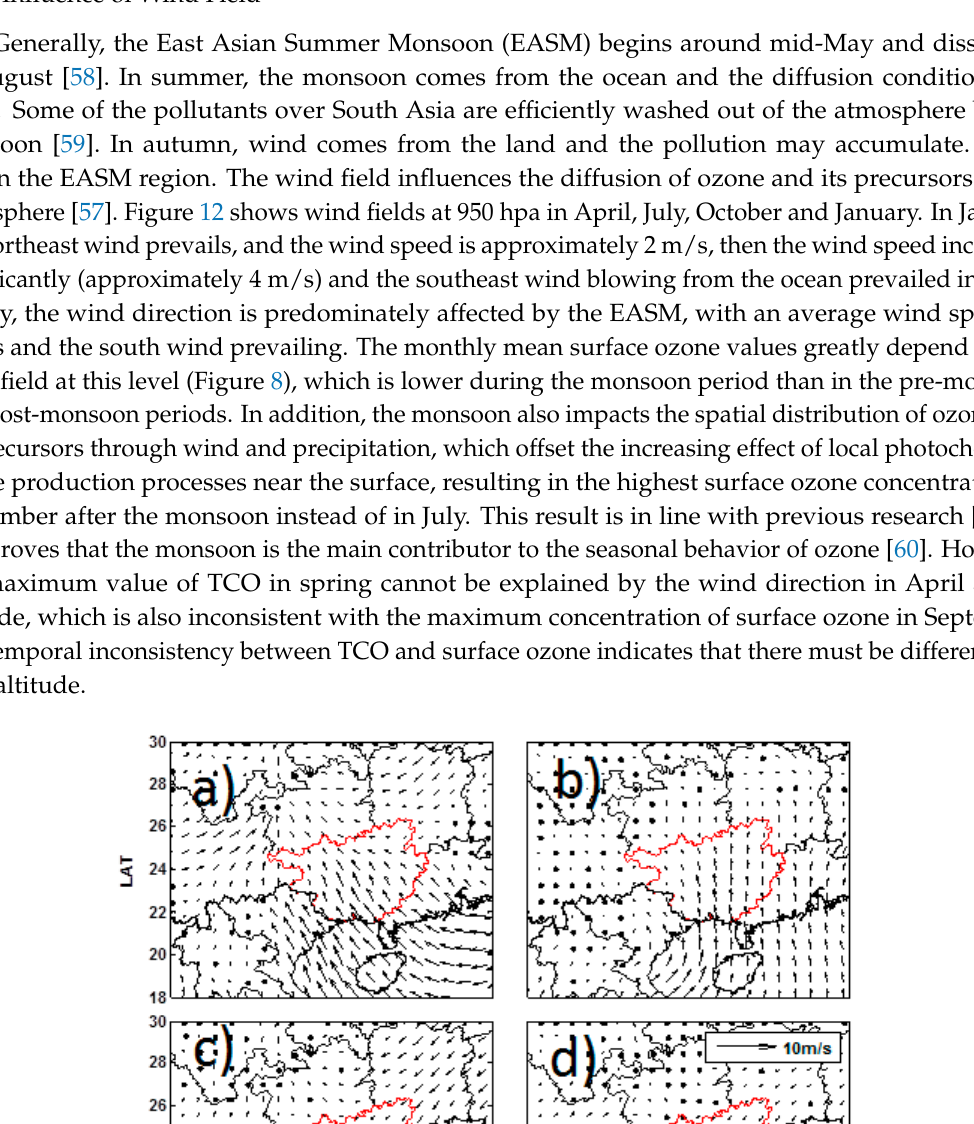
Figure 13. Monthly winds at 800 hPa in 2014 based on ECMWF. ( a ) April; ( b ) July; ( c ) October; ( d ) January. 3.3.2. Long-Range Transport and Pollutant Accumulation The five-day air mass back trajectories were obtained from the HYSPLIT model. Figure 14 shows an example of the HYSPLIT backward trajectory results for air masses over GX. Three points listed in Table 1 were selected for the backward trajectory analysis at altitudes of 500 m, 4 km and 8 km in January, April, July and October of 2014.